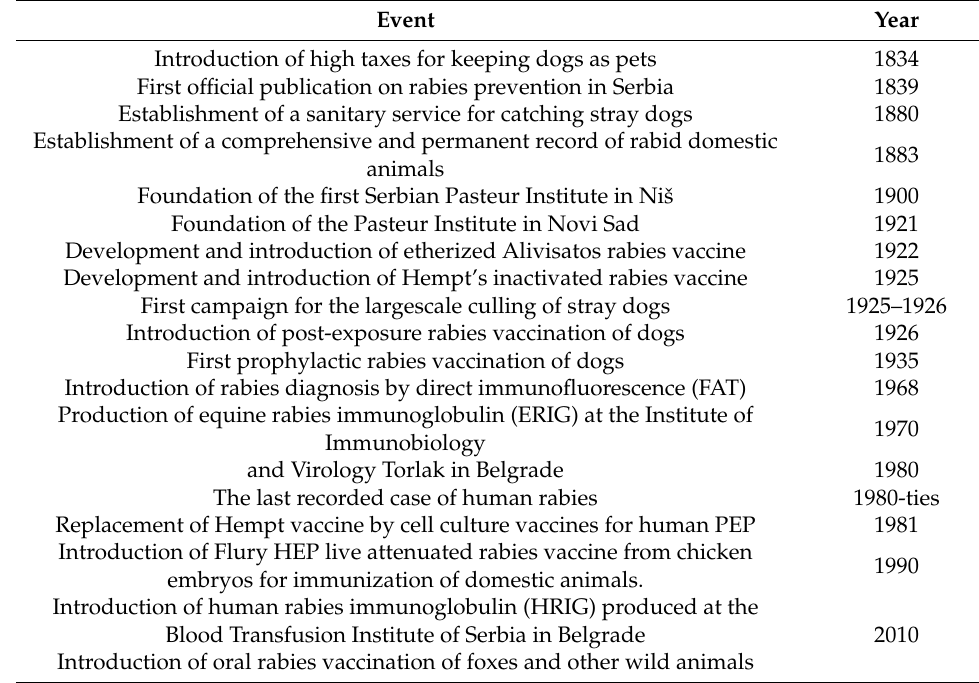
Table 2. Timeline of rabies prophylaxis in